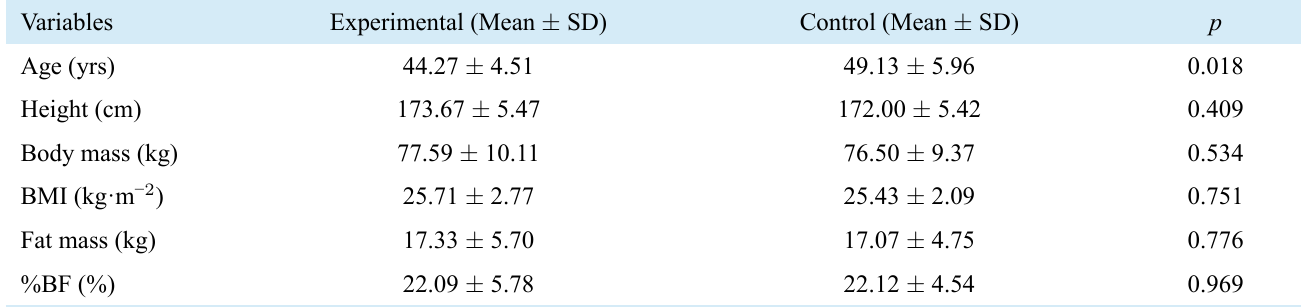
TABLE 2. Physical characteristics of